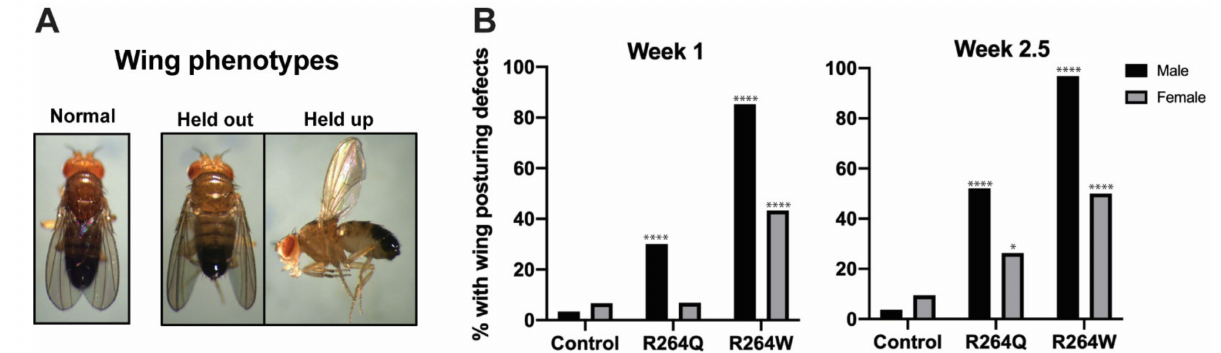
Figure 7. Expression of the LamC R264Q and R264W transgenes in the indirect flight muscles caused wing posturing defects. ( A ) Representative examples of the wing posturing defects. “Normal” indicates the typical wing posture of control flies expressing the Act88F Gal4-driver alone. “Held out” and “held up” are examples of wing posturing defects in adults expressing LamC R264Q in the indirect flight muscles. ( B ) Wing posturing defects were assayed in 1- and 2.5-week-old adults and plotted as a percentage of the total for each genotype. For 1-week-old adults n = 30–88; for 2.5-week-old adults n = 24–81. Transgenic flies expressing mutant lamins were compared to controls and separated by sex. * p < 0.05, **** p <